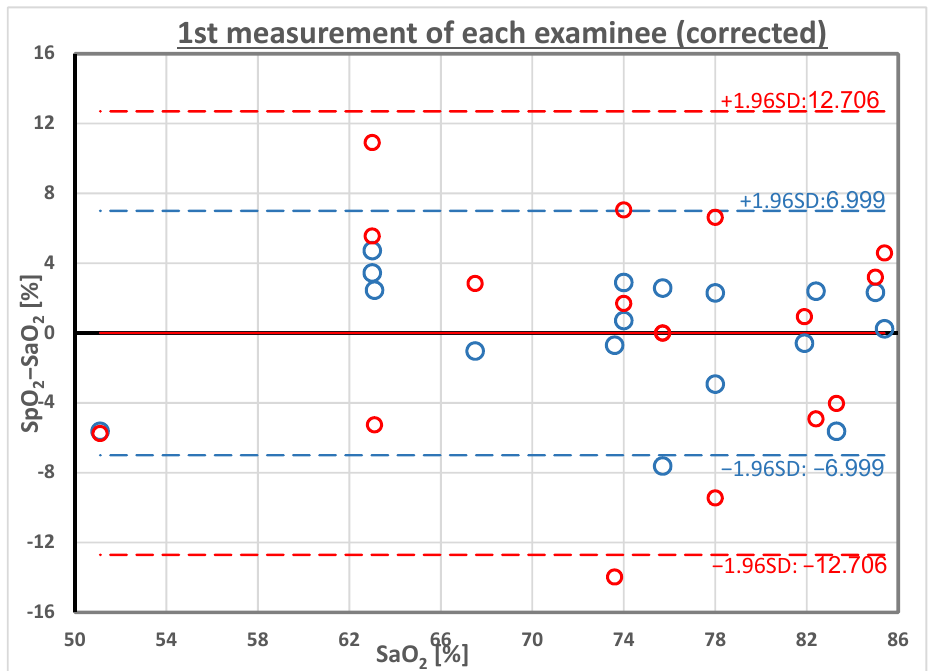
Figure 5. The modified Bland-Altman plot: SpO 2 – SaO 2 as a function of SaO 2 for the two SpO 2 measurement techniques, after the calibration of Equation (3). The greater limits of agreement for the SpO 2 _R-IR (red circles) relative to those for SpO 2 _2IR (blue circles) reflect the difference in their standard deviations: 6.5% versus 3.6%, respectively.